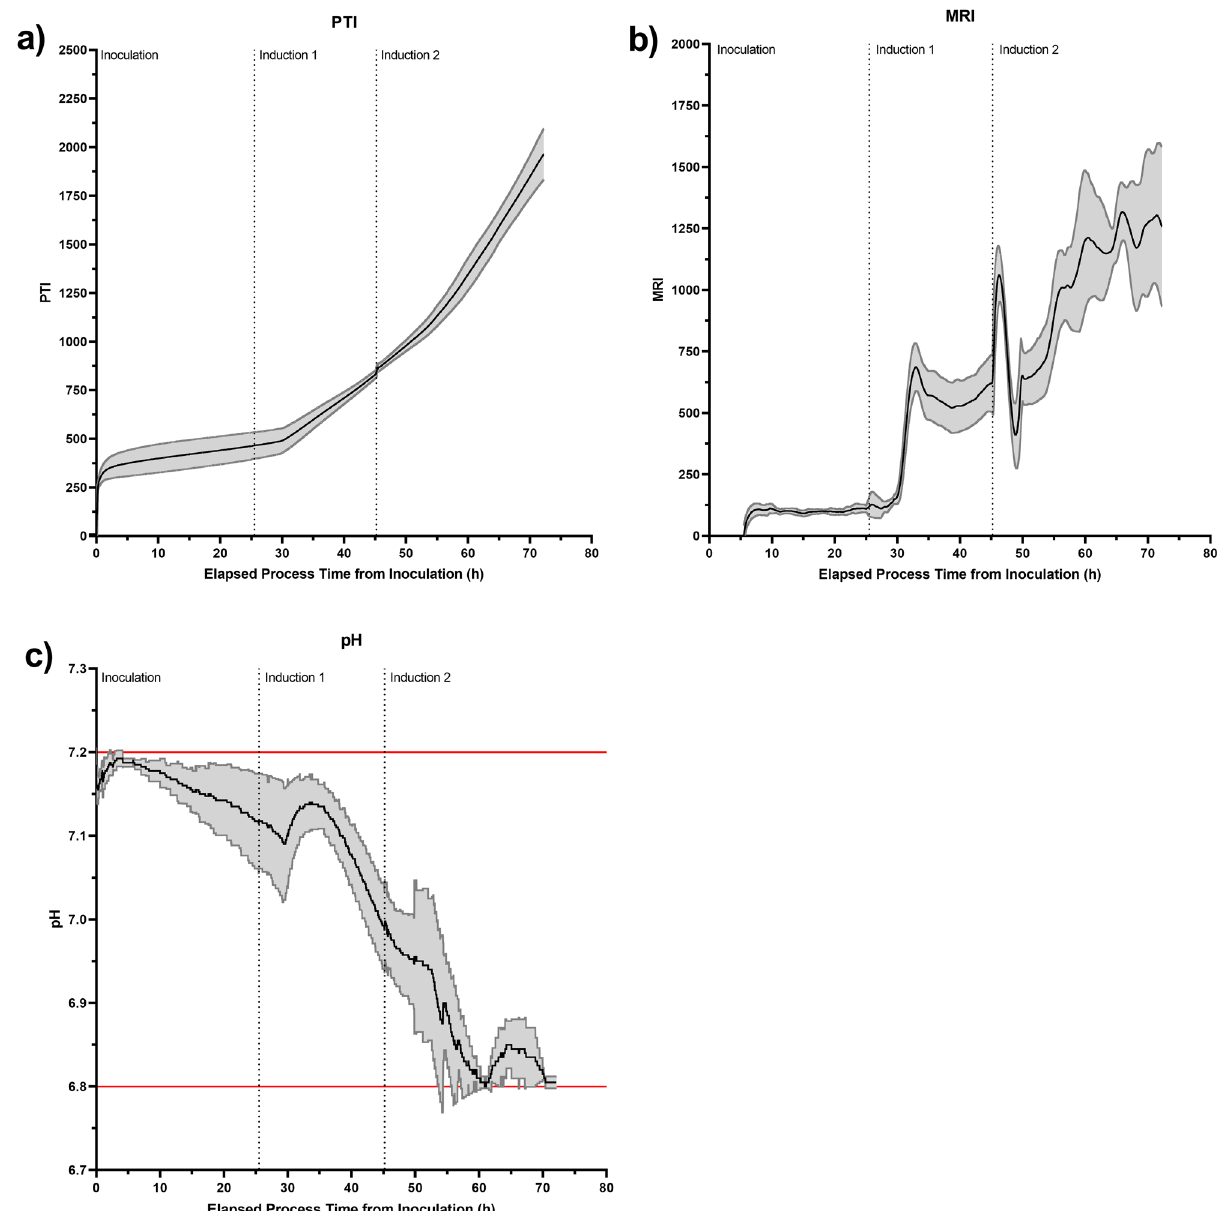
Figure 2. Unoptimised HEK293T-based PCL HIV-1-GFP LVV production bioprocess involving the passive monitoring of ( a ) PTI ( b ) MRI and ( c ) pH to gain baseline monitoring data. Black traces indicate the mean